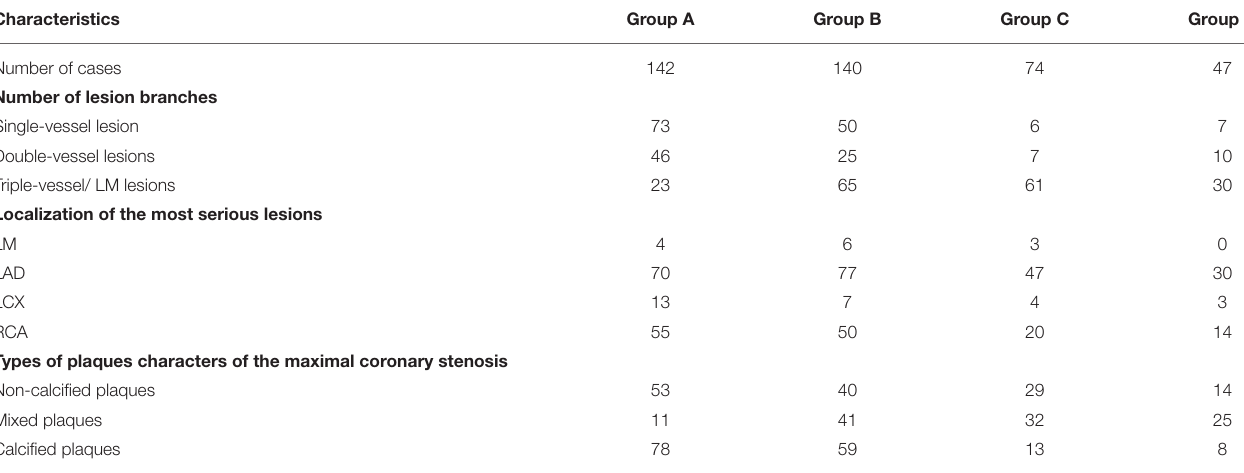
TABLE 2 | Lesion characteristics of coronary CTA in the four subgroups.